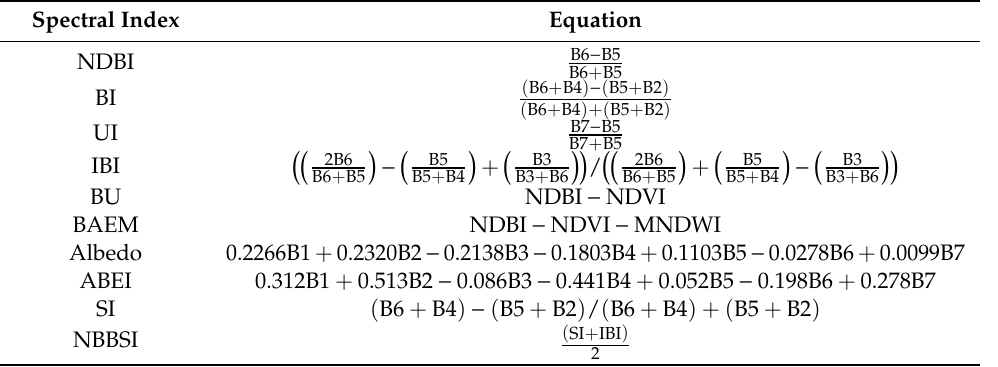
Table 4. Spectral indices used in this